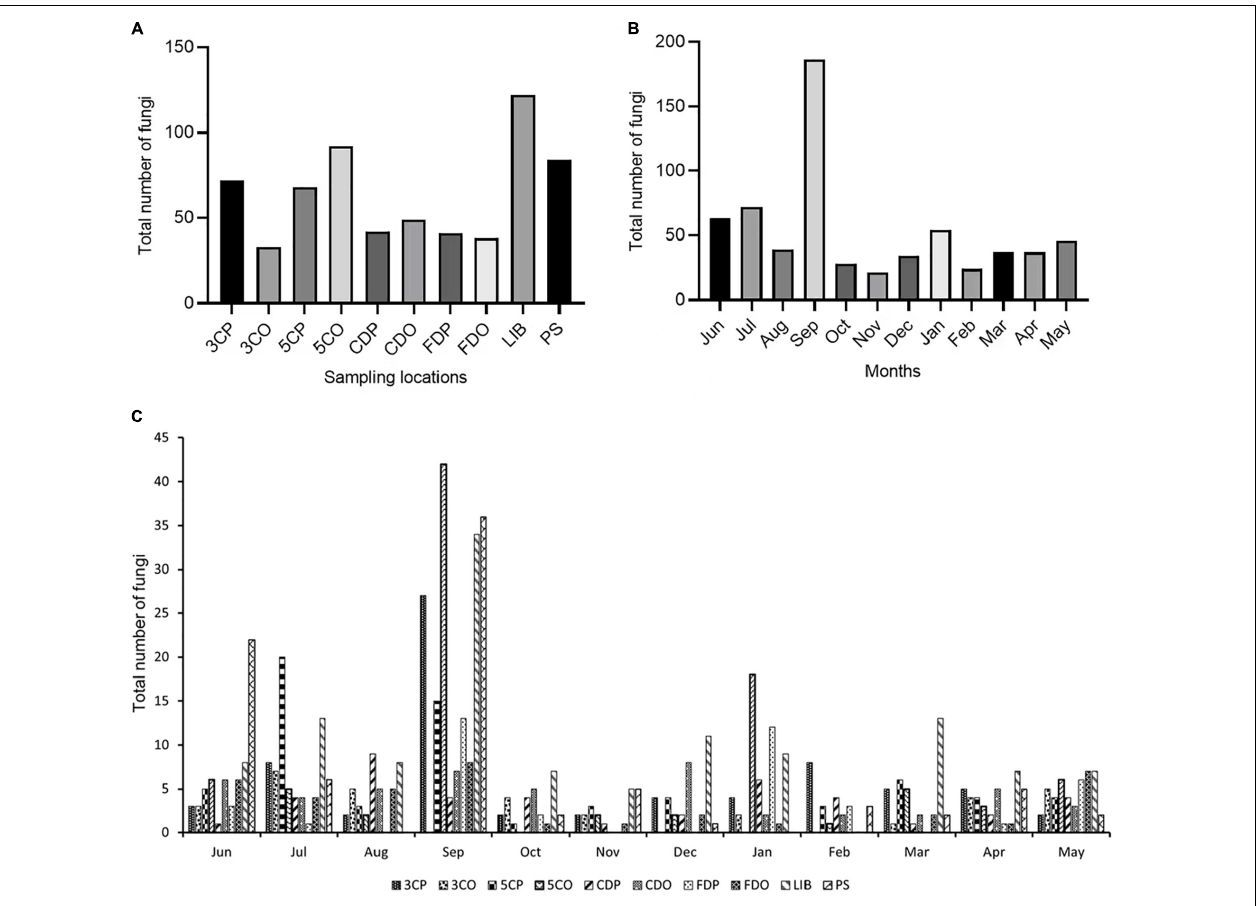
FIGURE 2 | Total number of fungi isolated from different locations (A) and months (B,C) . 3CP, Canteen 3 Peak; 3CO, Canteen 3 Off-peak; 5CP, Canteen 5 Peak; 5CO, Canteen 5 Off-peak; CDP, Chinese student Dorm Peak; CDO, Chinese student Dorm Off-peak; FDP, Foreign student Dorm Peak; FDO, Foreign student Dorm Off-peak; LIB, Library; PS, Peiyang Square.